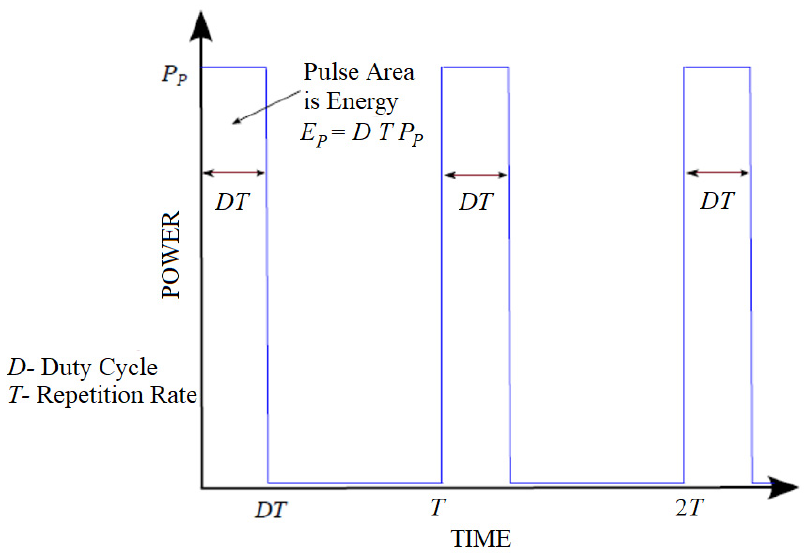
Figure 11. Pulsed power profile defined in the JSR Micro study.